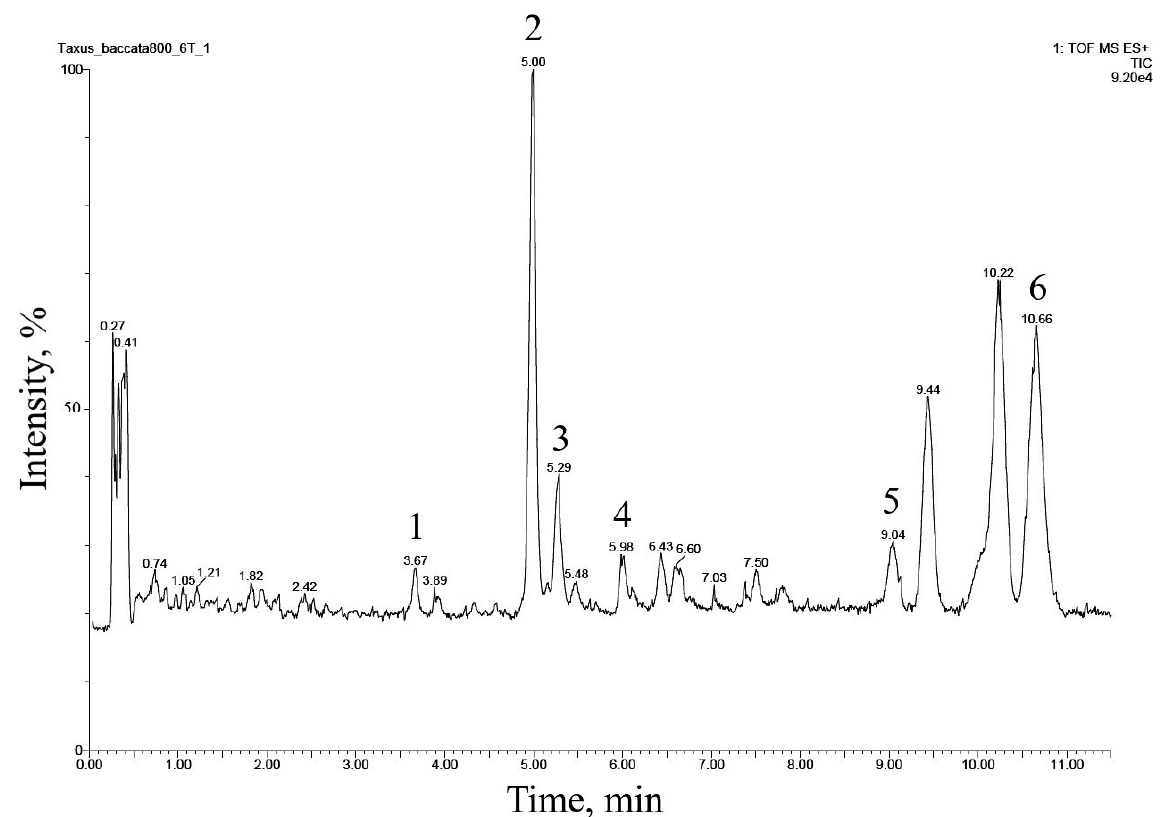
Figure 2. UPLC–ESI-MS chromatogram (total ion current, positive ion mode) of an alcohol extract from the biomass of T. baccata callus cell culture ( Tb-nbg /R-NB-ac line grown in a B5-PB-ac medium, 74 days of 42nd subcultivation). The description of peaks 1 – 6 is given in Table 3. Table 3. Results of UPLC–ESI-MS analysis (positive ion mode) of an alcohol extract from the biomass of T. baccata callus culture ( Tb-nbg R-NB- ac line grown in a B5-PB-ac medium, 74 days of 42nd subculturing cycle). Peak numbers correspond to those in Figure